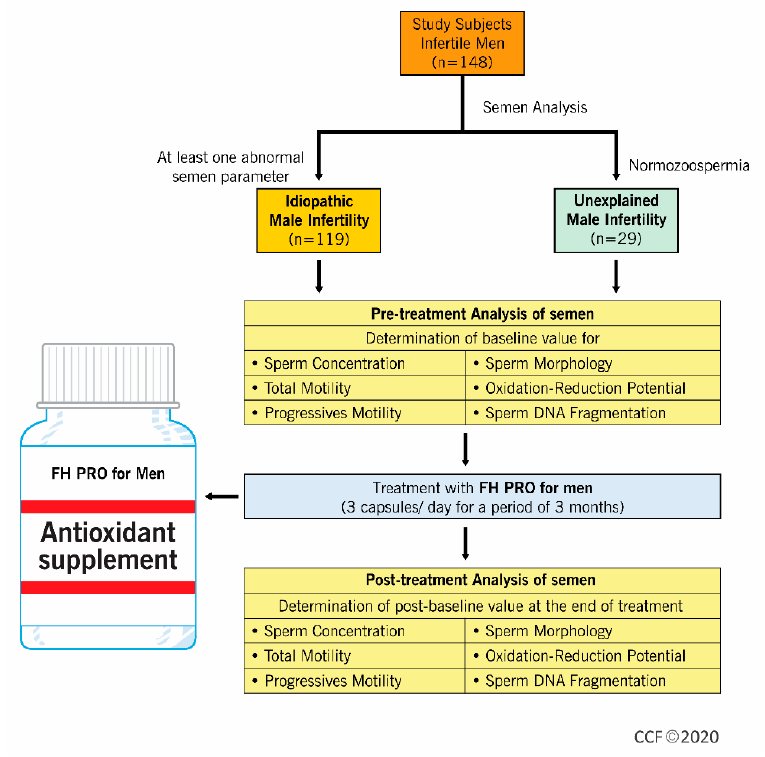
Figure 1. Flow diagram depicting the experimental design.